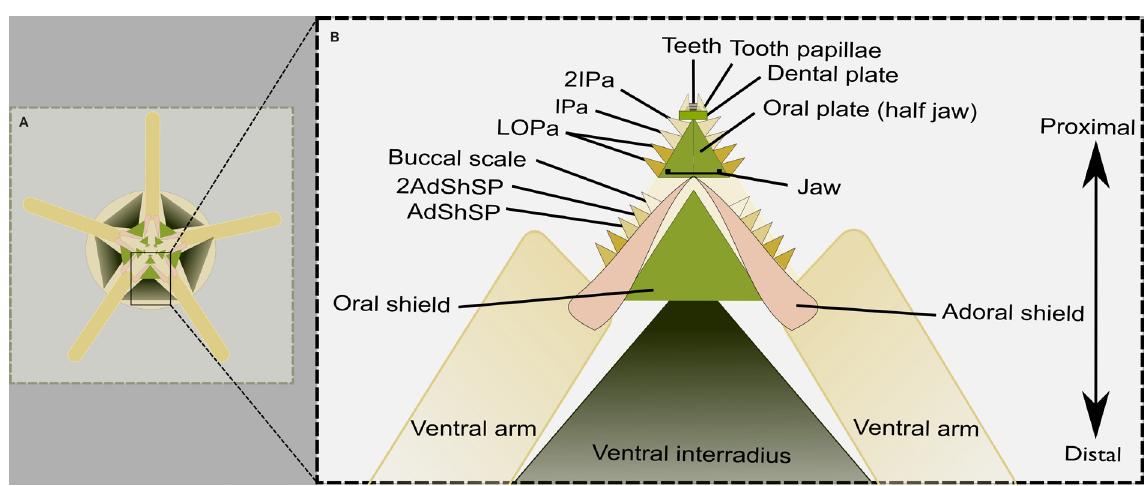
Fig. 4. Oral papillae sensu lato. A . Ventral side of a schematic brittle star. B . One angle of the oral frame includes a dental plate (DP), two oral plates (= half-jaws) (OP), two adoral shields (AdSh), and one oral shield (OSh), positioned from proximal towards distal. The typical position of teeth, tooth papillae, secondary infradental papillae (2IPa), infradental papillae (IPa), buccal scale, secondary adoral shield spine (2AdShSp), adoral shield spine (AdShSp) on DP, OP and AdSh are illustrated, respectively. The presence / absence, number and shape of each papilla vary among different taxa.